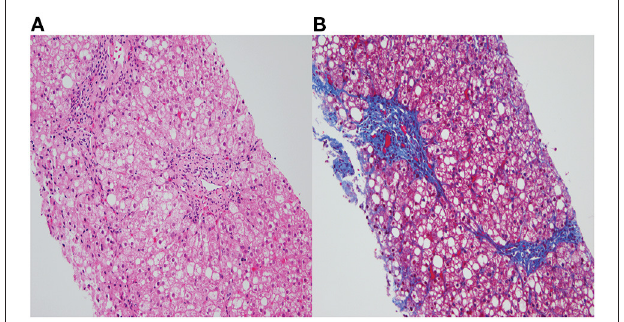
FIGURE 2 | Timeline of our patient’s presentation throughout diagnosis and treatment of Wilson disease and GLUT-1 deficiency.